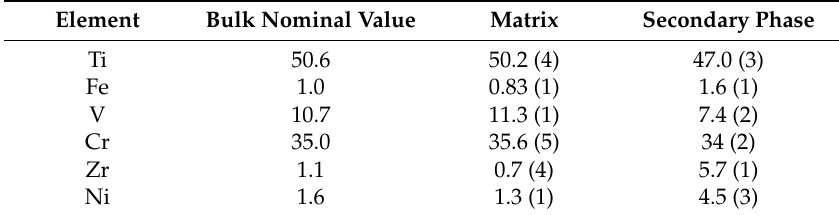
Table 1. Nominal and measured atomic percentage of the as-cast co-melt 52Ti-6V-6FeV-36Cr + 4%Zr 7 Ni 10 . Uncertainties on the last significant digits are quoted in parentheses.